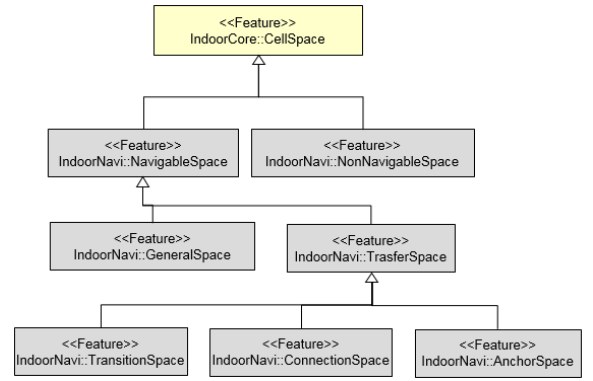
Figure 6. Cell Classification (OGC 2014)